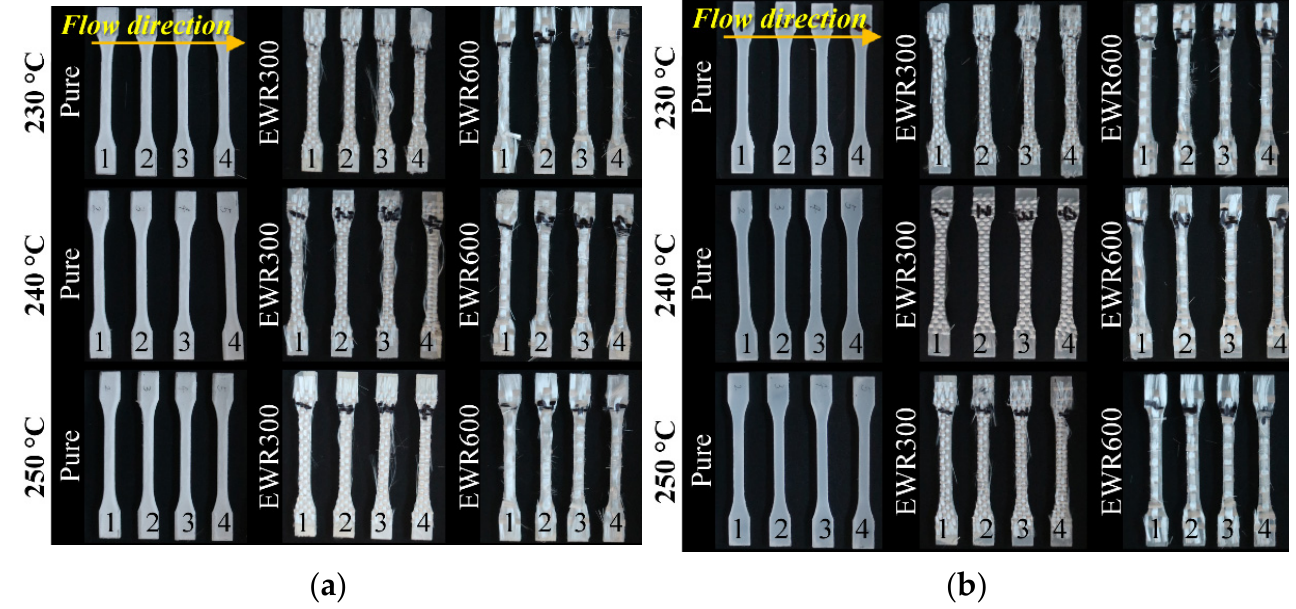
Figure 5. Pictures of the foamed ( a ) and unfoamed ( b ) tensile samples. The numbers of 1, 2, 3, and 4 indicate the number for each type of samples.